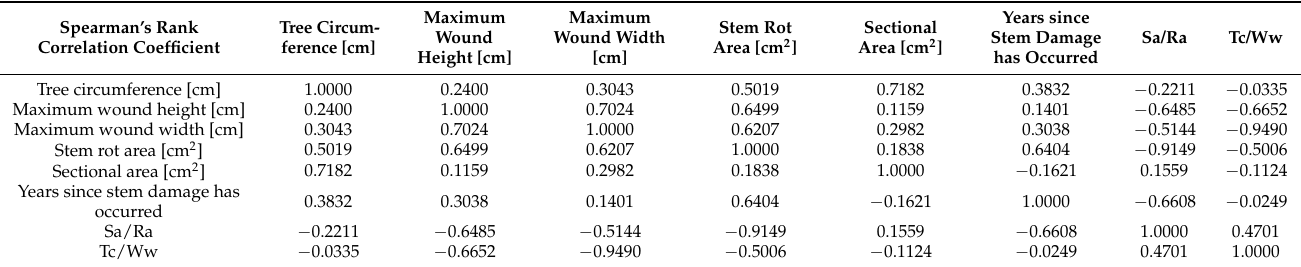
Table 2. Spearman’s rank correlation coefficient for the studied characteristics and indexes.